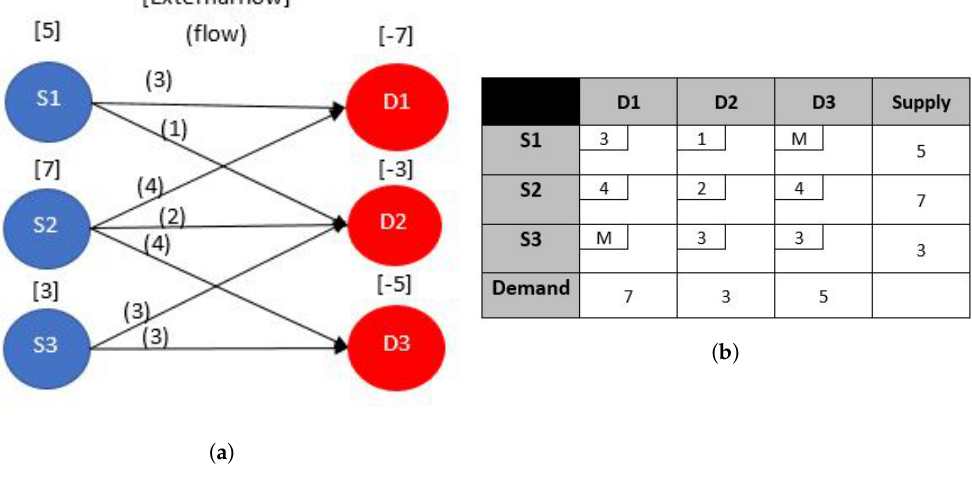
Figure 4. An illustrative example of a simple transportation problem. ( a ) NFP model of the transportation problem; ( b ) Tableau of a transportation